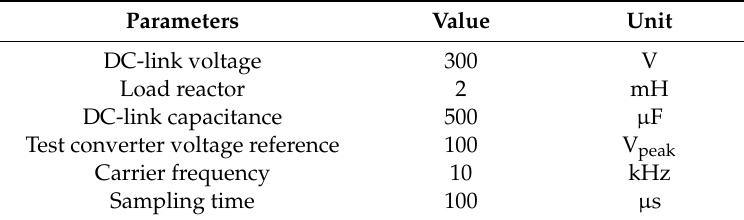
Figure 9. Configuration of the experiment hardware. Table 2. Circuit parameters for the experiments and simulation.